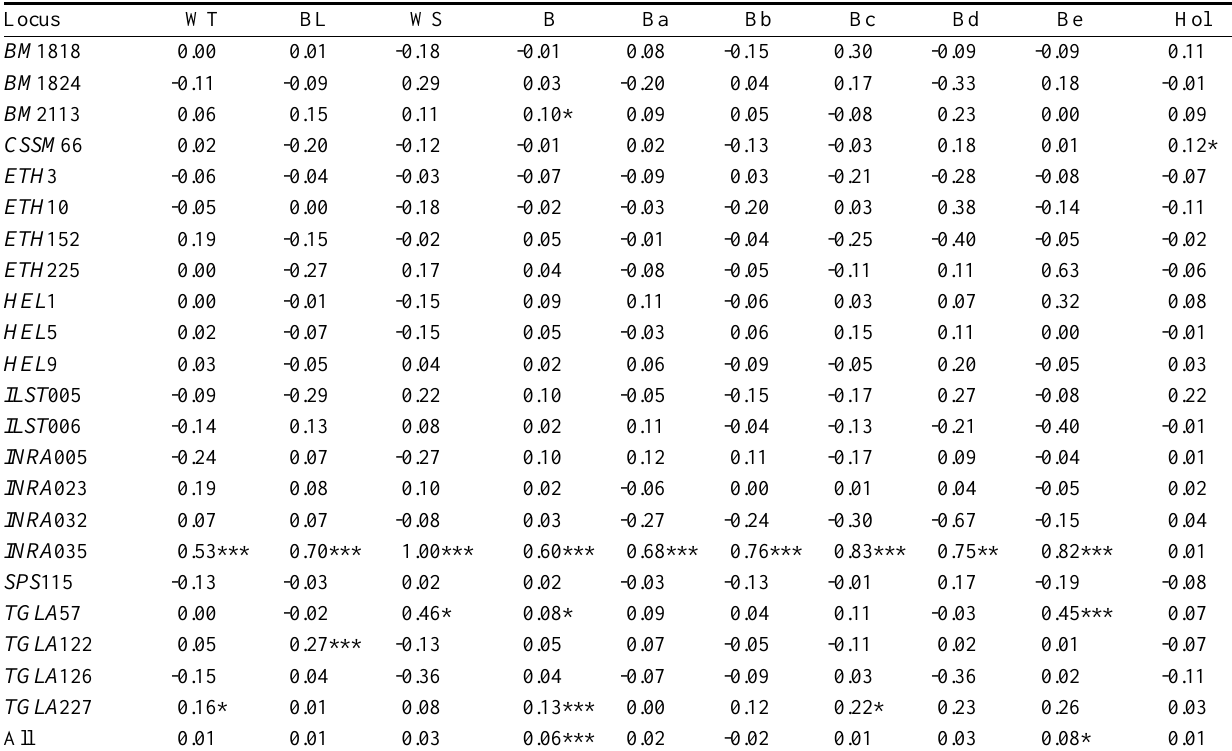
Table 3. Inbreeding estimates ( F is ) within Hanwoo and Holstein populations based on 22 microsatellite loci